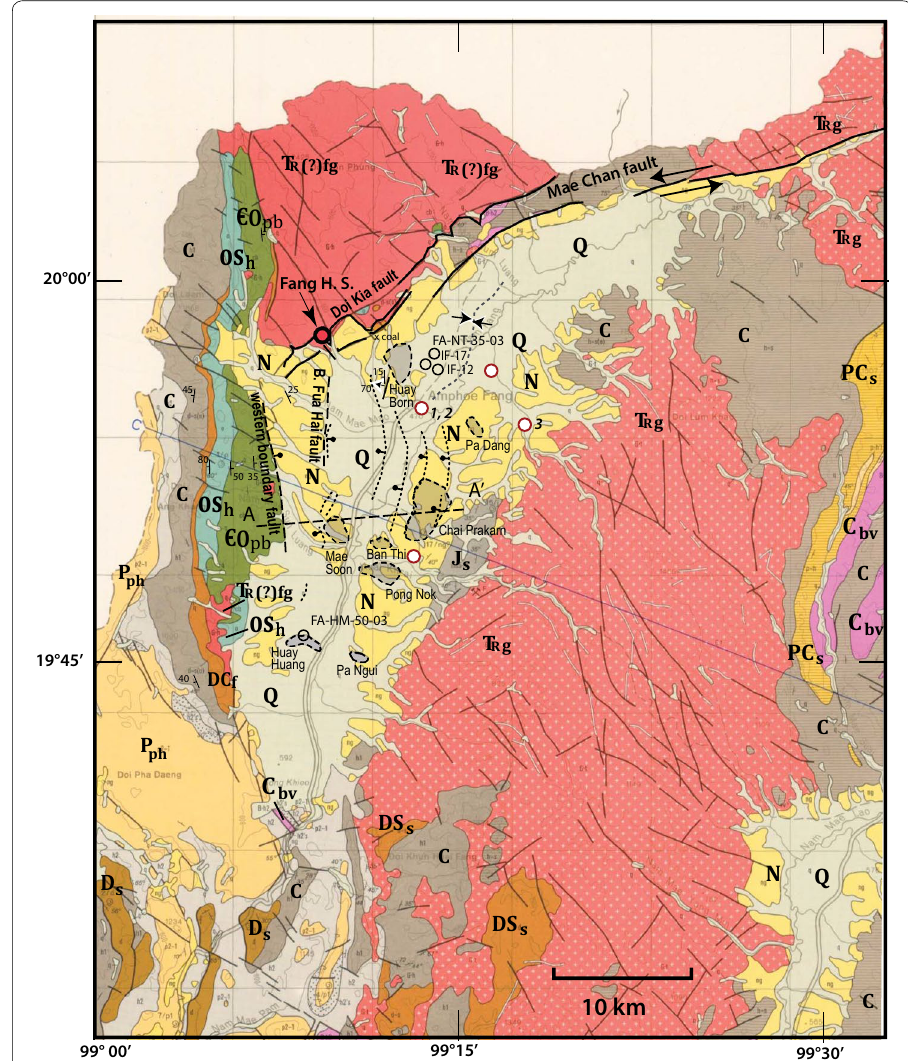
Fig. 2 Geologic map of the Fang Basin area from von Braun and Hahn (1981) showing location of Fang Hot Springs. Formation names from Imsamut and Krawchan (2005) and the Thailand Department of Mineral Resources (2013). We recognize that mapping since 1981 has somewhat changed the outcrop areas and assigned ages. Solid lines are faults related to Fang geothermal area, dotted lines are subsurface faults mapped by Kongmongkhol and Chantraprasert (2015). Symbols explained in Fig.